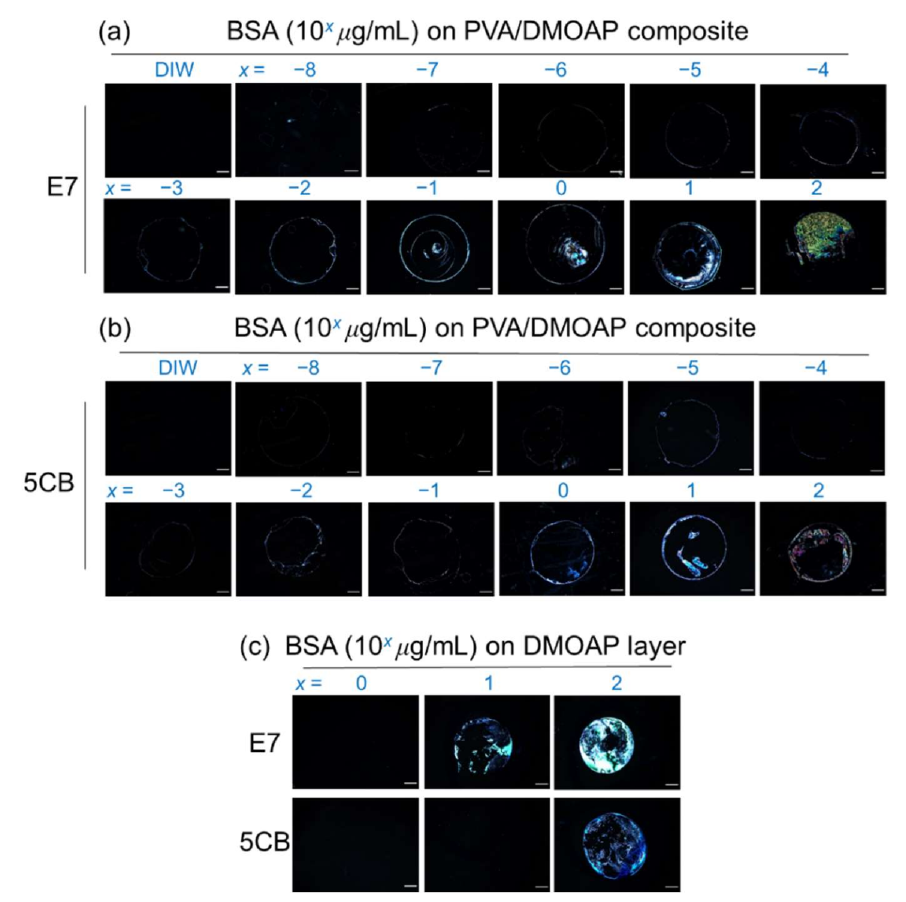
Figure 5. Optical texture of E7 and 5CB at various concentrations of BSA on glass substrates coated with the PVA/DMOAP composite. Aqueous solutions of BSA at various concentrations (10 − 8 to 10 2 µ g/mL) were immobilized on PVA/DMOAP-coated glass substrates for LC-based detection with ( a ) E7 and ( b ) 5CB as the sensing media. ( c ) A parallel study on DMOAP-coated glass substrates was undertaken with a BSA concentration range of 10 0 –10 2 µ g/mL. Scale bar: 500 µ